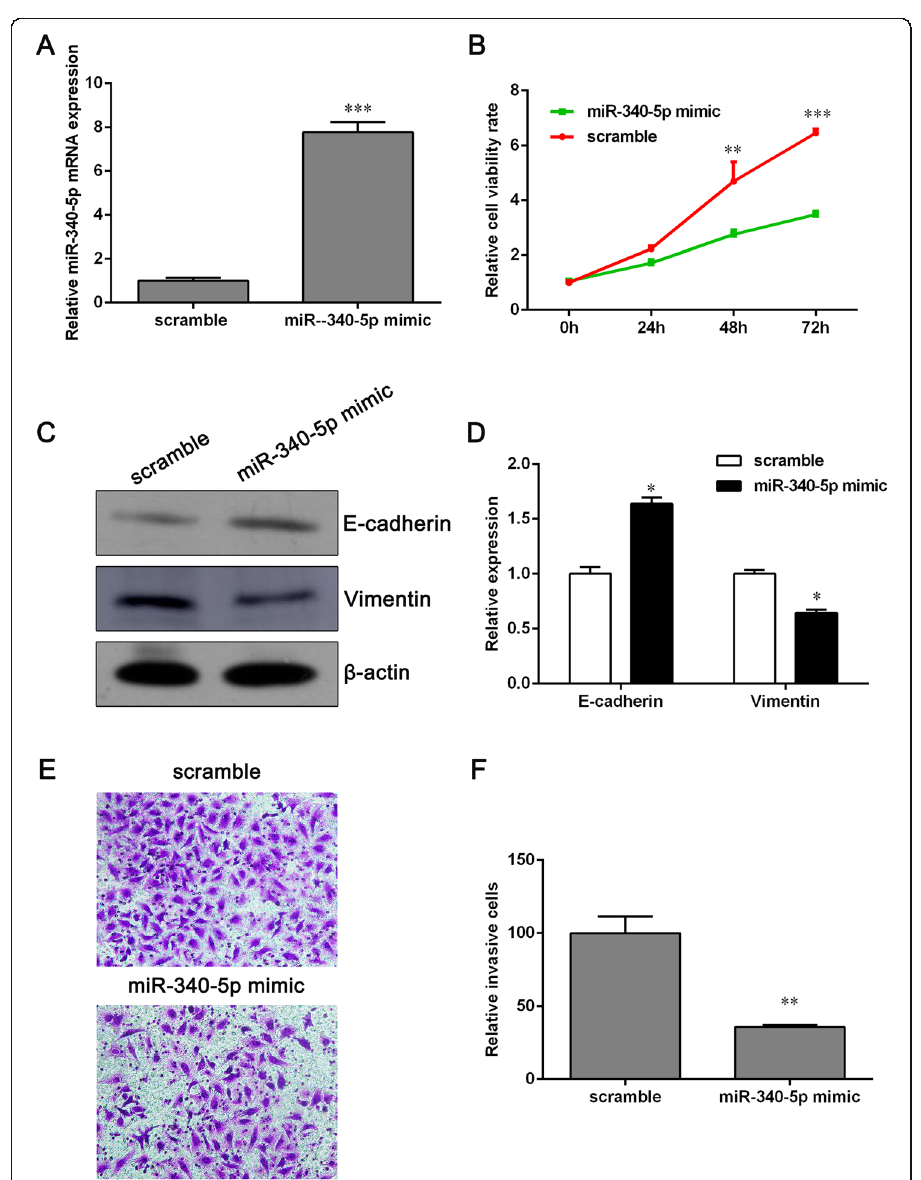
Fig. 2 Elevated miR-340-5p inhibits the proliferation and invasion of NCI-H1650 cells. a The expression of miR-340-5p in NCI-H1650 cells transfected with miR-340-5p mimics was determined using qPCR. b Cell viability was determined using CCK-8. c Western blot assays were conducted to detect the expressions of E-cadherin and vimentin. d The data represent relative protein expression. e Transwell invasion assays were performed to assess the effect of overexpressed miR-340-5p on NCI-H1650 cell invasive ability. f The number of invaded cells was analyzed using GraphPad Prism 5.0. Data